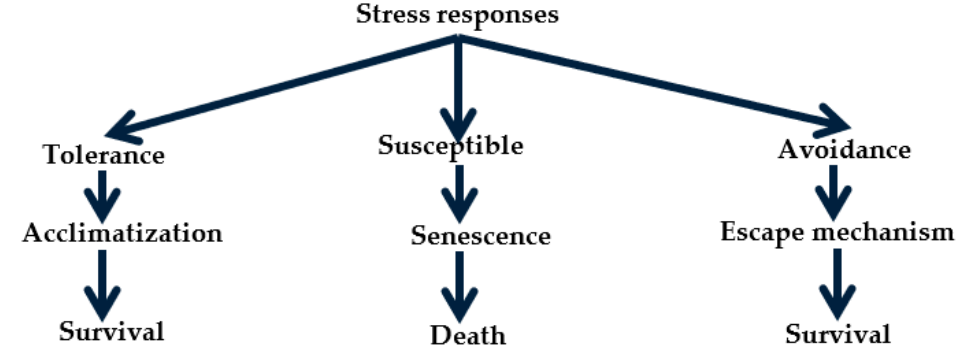
Figure 2. Plant response mechanisms to drought stress.